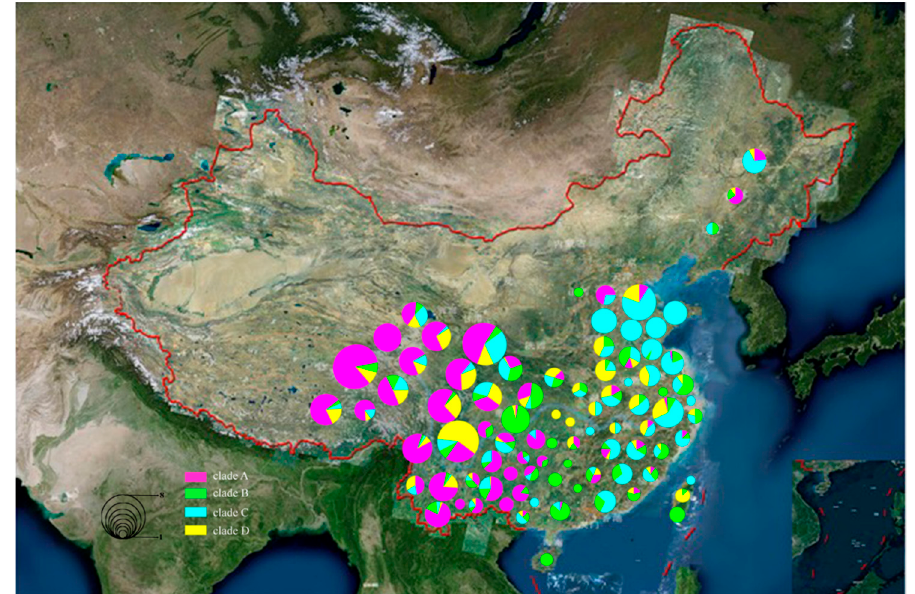
Figure 2. According to the origin of each individual in each clade, 2466 pigs representing 87 local breeds are shown on a map of China. Different clades are represented by different colors. Circle size indicates the number of individuals; for example, circle 1 contains one individual, circle 2 contains ≤ 5, circle 3 contains ≤ 10, circle 4 contains ≤ 30, circle 5 contains ≤ 50, circle 6 contains ≤ 100, circle 7 contains ≤ 150, and circle 8 contains >150.